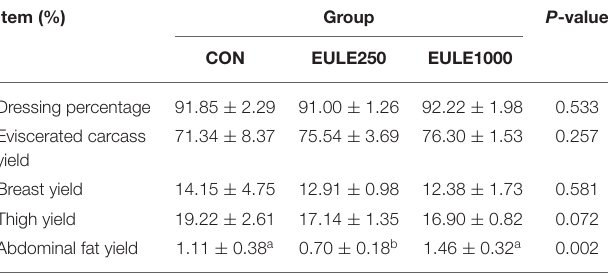
TABLE 4 | Effects of EULEs on the slaughter performance of broilers.